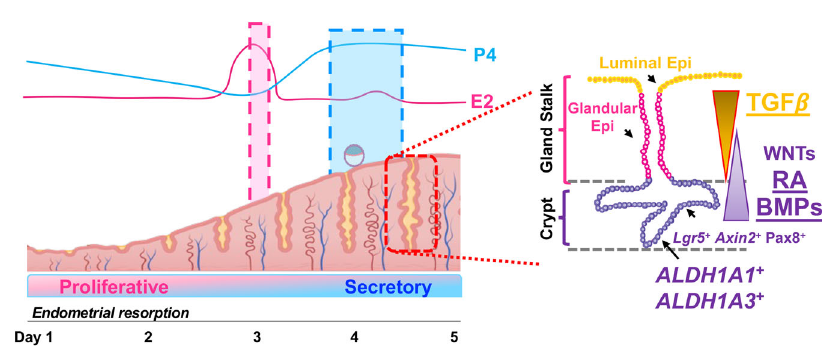
Fig. 7 Detection of retinoid- and BMP-signaling pathways in control and Smad2/3 cKO mice. a – d Cross-sections from 17-week-old control ( a , b ) and Smad2/3 cKO ( c , d ) mice stained with ALDH1A1 antibody. ALDH1A1 is enriched in the crypts of the mouse endometrial glands. e – h ALDH1A2 IHC in the uteri of control ( e , f ) and Smad2/3 cKO mice ( g , h ) ALHD1A2 is localized to the subepithelial stromal compartment. i – l ALDH1A3 IHC in control ( I , j ) and Smad2/3 cKO ( k , l ) mice shows enrichment in the crypts of endometrial glands. m – p pSMAD2 IHC in control ( m , n ) and Smad2/3 cKO ( o , p ) uterine cross- sections. Decreased pSMAD2 is observed in Smad2/3 cKO mice. q – t pSMAD1/5 IHC in the uterine cross-sections of control ( q , r ) and Smad2/3 cKO ( s , t ) mice shows increased pSMAD1/5 reactivity in the uteri of Smad2/3 cKO mice. IHC experiments were performed in >3 mice per genotype. u Quantitative PCR analysis of uterine epithelium from control ( n = 4) and Smad2/3 cKO ( n = 6) for genes involved in retinoid signaling ( Cyp26a1, Aldh1a1, -1a2, -1a3, Lrat , and Rbp4 ) or BMP signaling ( Id1, Id2, Id3, Id4 ). Histograms represent mean ± SEM analyzed by an unpaired two-tailed t -test.